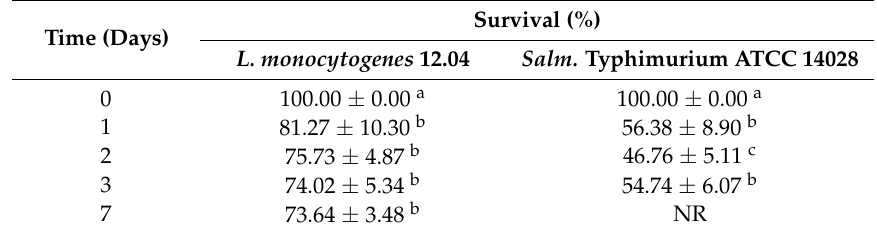
Table 2. Survival of L. monocytogenes 12.04 and S. Typhimurium ATCC 14028 on the surface of “Bravo de Esmolfe” apples stored at 20 ◦ C for 7